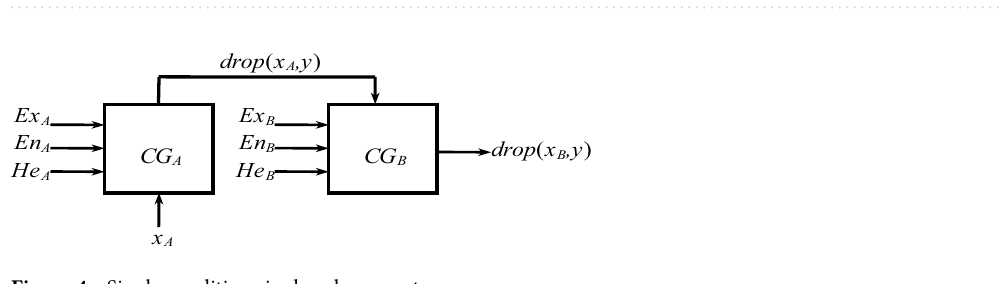
Figure 4. Single condition single rule